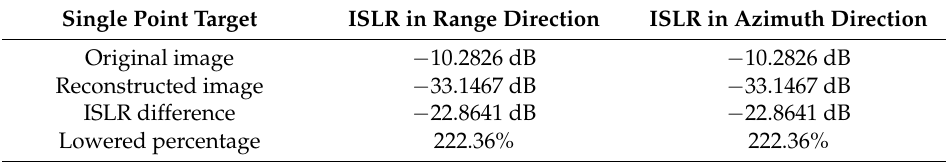
Table 2. ISLR of the original image and reconstructed image in range and azimuth directions.